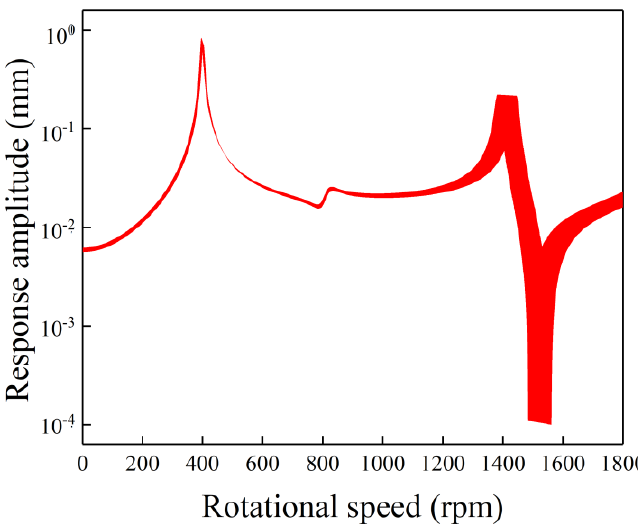
Figure 6. The bounds of uncertain gravity response versus rotational speed by the CIM with a 5% deviation in Young’s modulus.